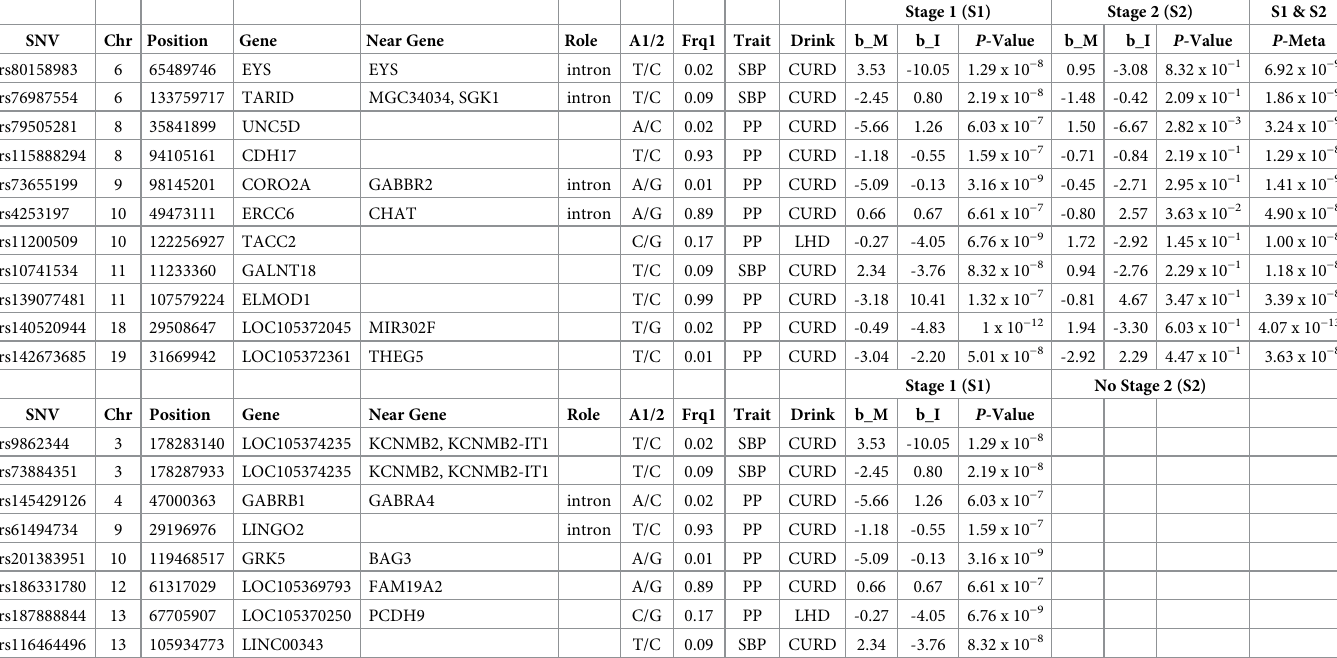
Table 3. Potential novel SNVs/Genes associated with BP traits in African ancestry.